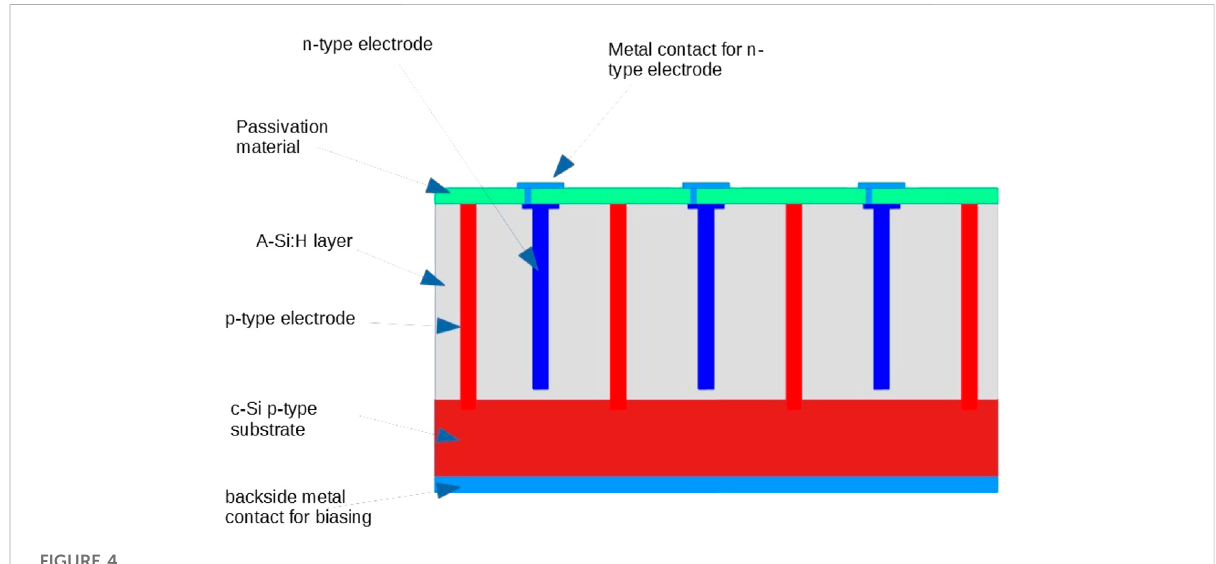
FIGURE 4 Lateral layout of a 3D a-Si:H p-i-n